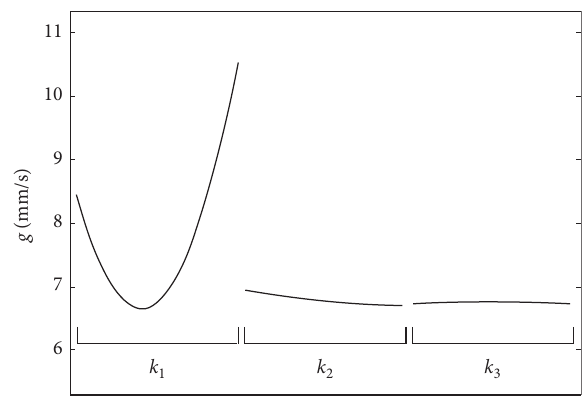
Figure 12: Main effect plots for k